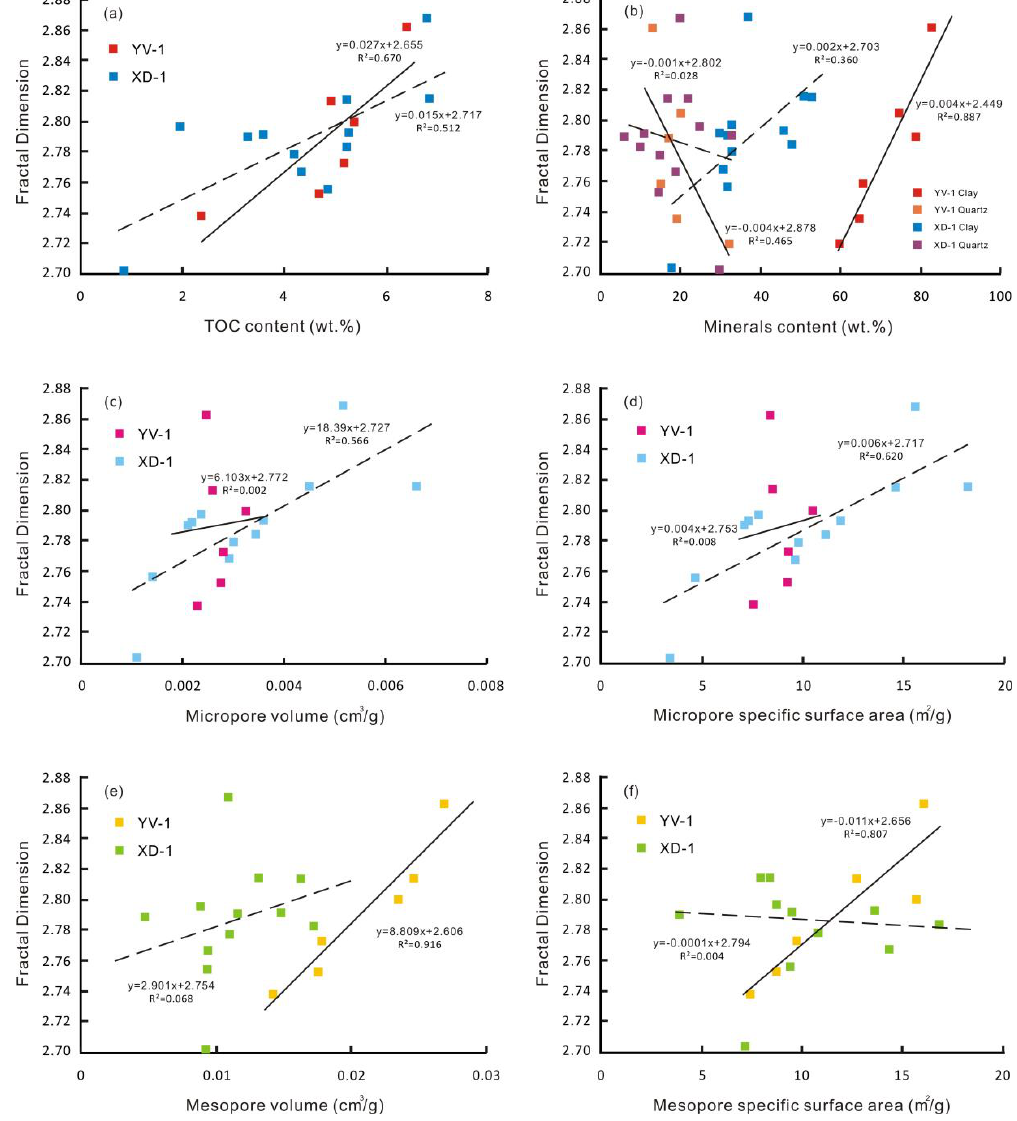
Figure 16. Relationships between fractal dimension and TOC content ( a ), clay content and quartz content ( b ), micro-PV ( c ), micro-SSA ( d ), meso-PV ( e ), meso-SSA ( f ) of transitional Longtan Shale samples from YV-1 and